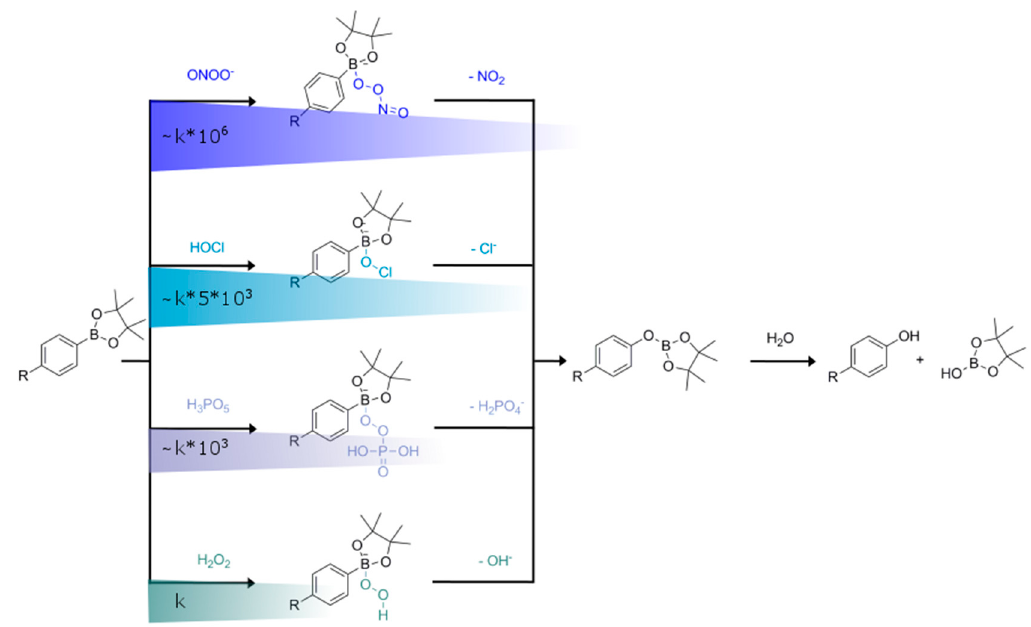
Figure 4. Oxidative cleavage reaction of boronate probes with peroxynitrite, hypochlorous acid, peroxymonophosphate and H 2 O 2 . The reaction rates depend on the–R group (e.g., fluorescein or resorufin and their substituents). The reactions are listed in order of decreasing reaction rates as found in the literature.